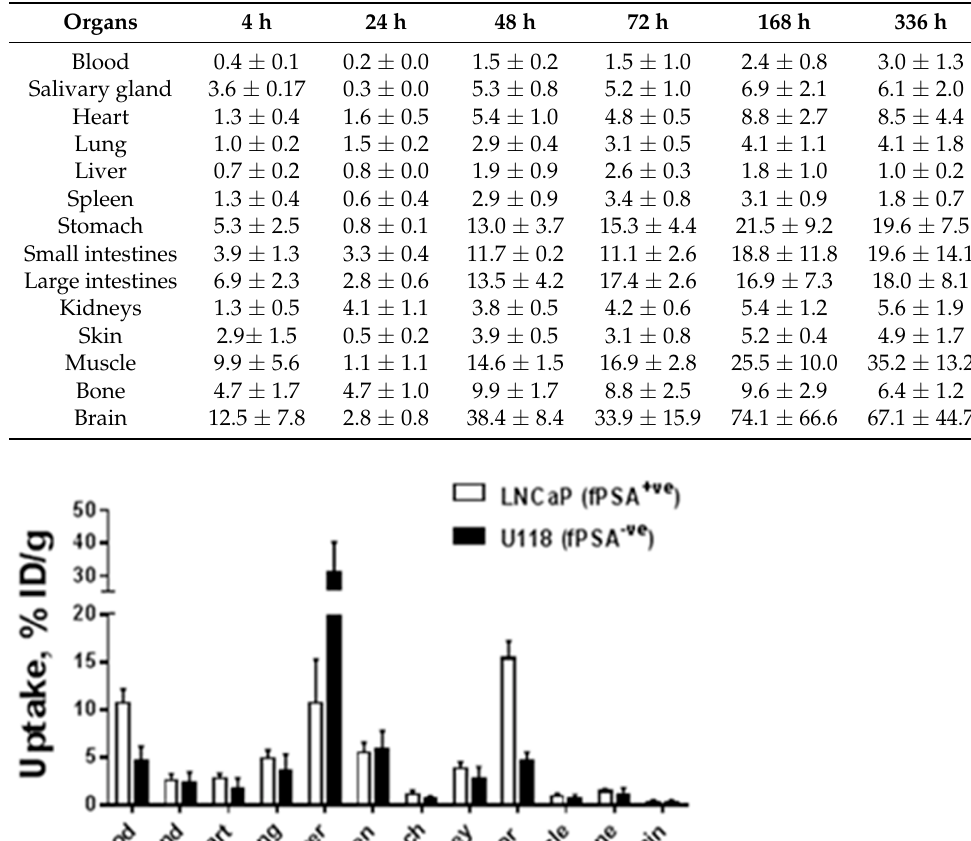
Table 2. Tumor-to-tissue ratios ± SD ( n = 4 per time point ) for 177 Lu-h5A10.